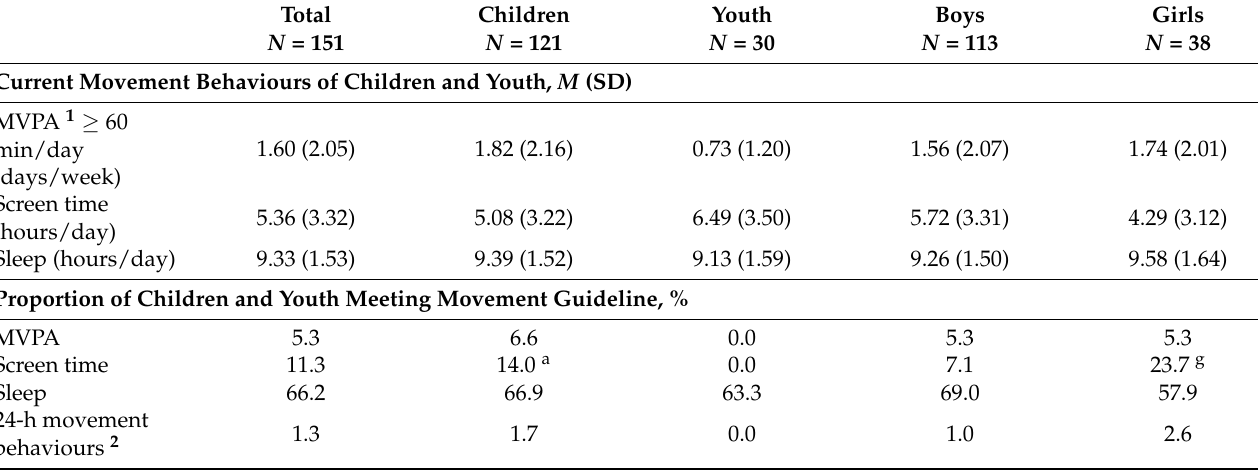
Table 2. Parent-reported movement behaviours of children (5–13 years) and youth (14–17 years) and proportion meeting the Canadian 24-h Movement Guidelines for Children and Youth during the acute phase (May 2020) of the COVID-19 pandemic ( N = 151).